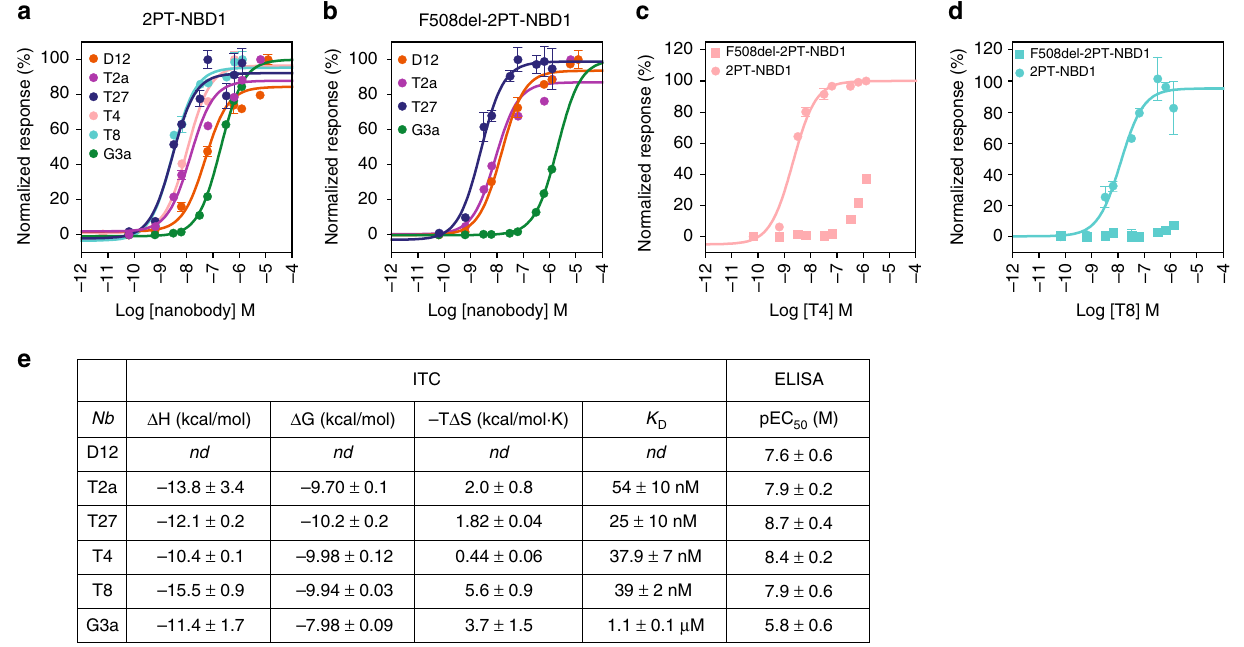
Structures of nanobody-NBD1 complexes . In order to identify the molecular basis of NBD1 stabilization by nanobodies, we determined the crystal structure of each complex. Crystallization trials were performed using either 2PT-NBD1 or Δ RI-NBD1 constructs, as removal of the RI is known to improve the protein stability and favor crystallogenesis 7 . We employed various crys- tallization strategies, using multiple stabilizing nanobodies at the same time and/or limited proteolysis to facilitate crystal forma- tion. Structures were solved by molecular replacement using published structures of human NBD1 and nanobodies.